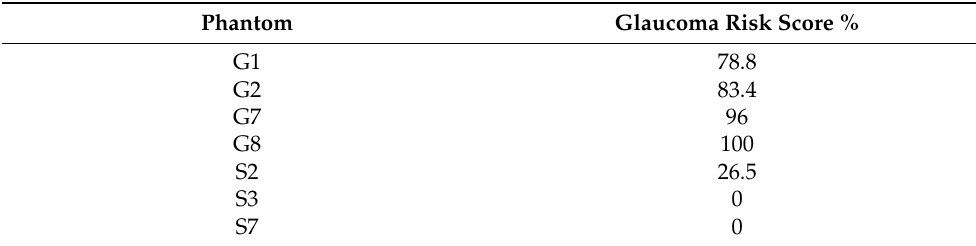
Table 5. Glaucoma risk score obtained for the validated